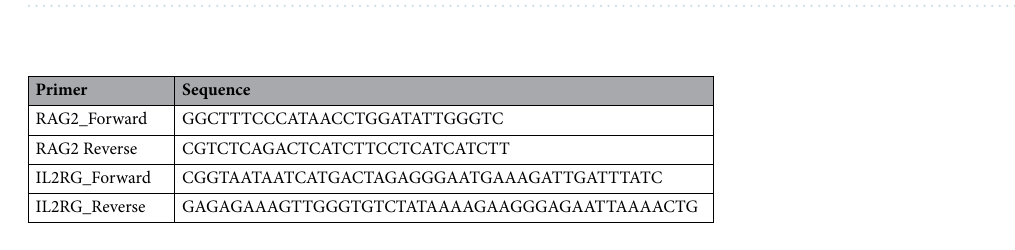
Table 2. Primers used to amplify sgRNA target